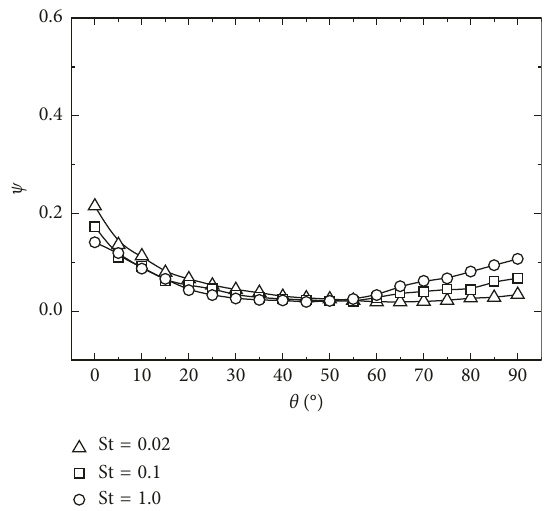
Figure 7: Orientation distribution of cylindrical particles for different St (Re � 200 and a � 15).